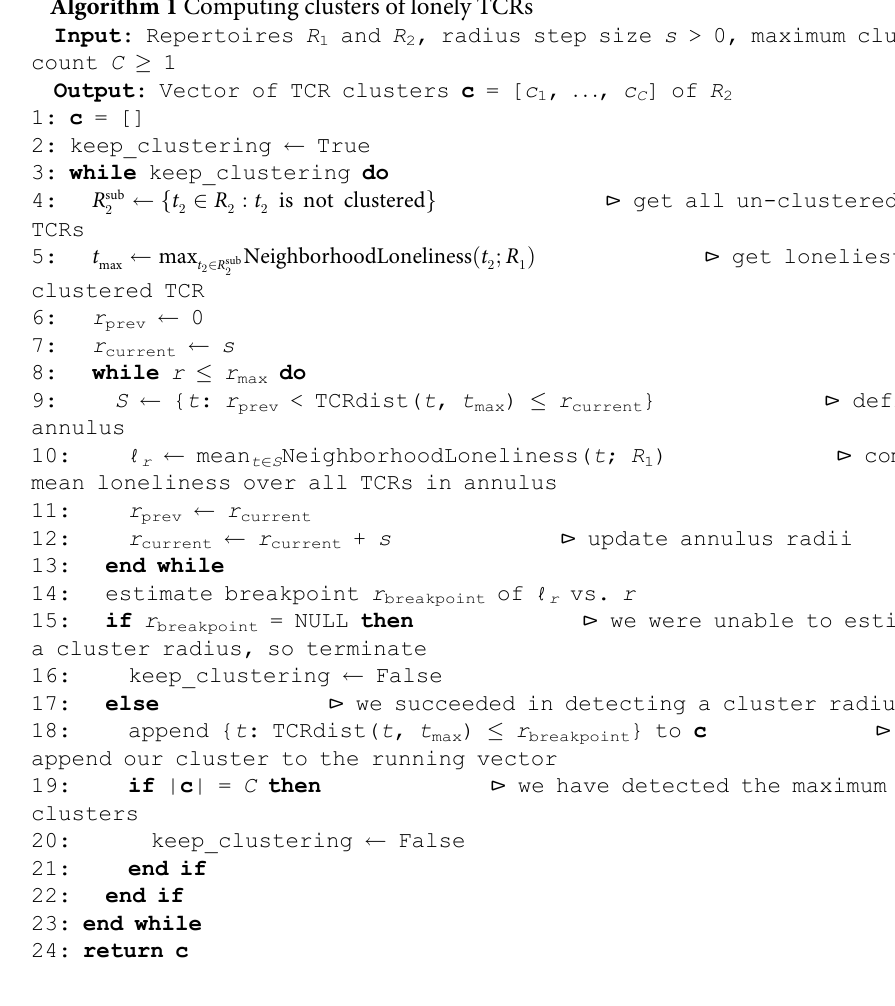
Algorithm 1 Computing clusters of lonely